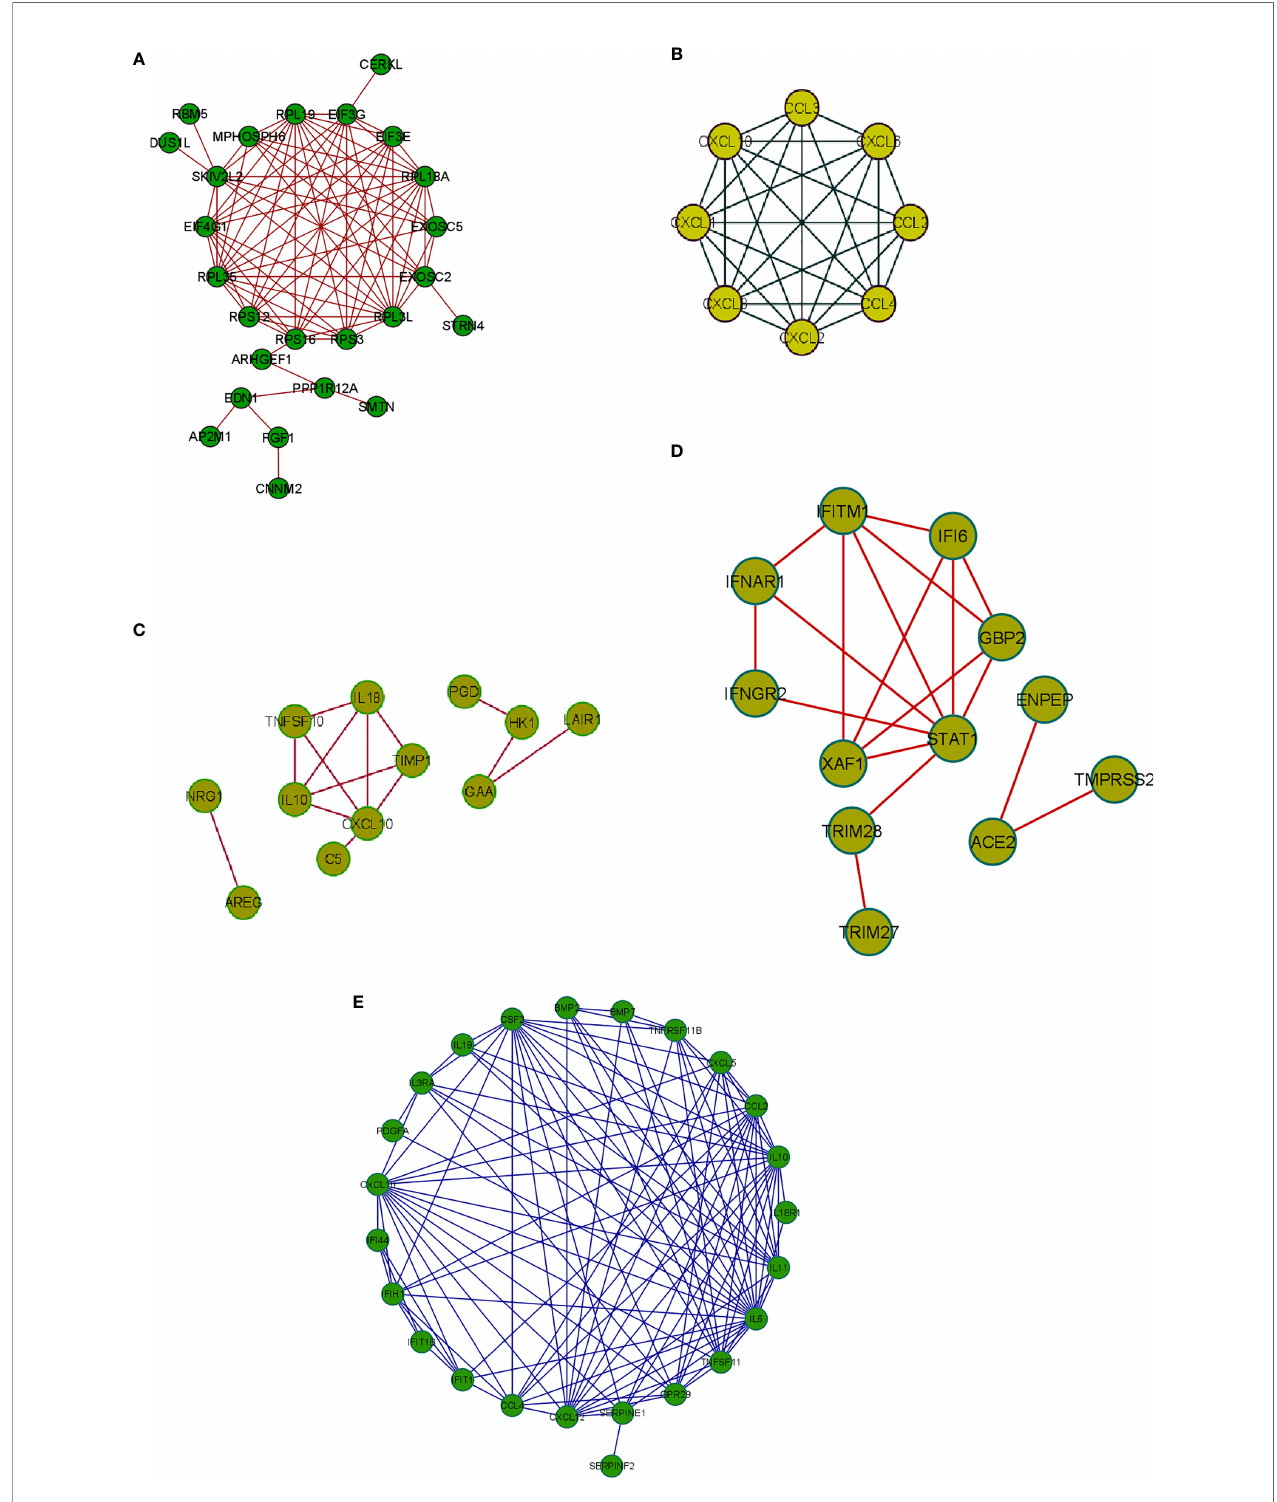
FIGURE 7 | The PPI network constructed using protein-coding DEGs from our study and other studies. (A) The PPI network with signi fi cant protein-coding DEGs in our research. (B) The PPI network from Xiong et al. study where the samples were the bronchoalveolar lavage fl uid. (C) The PPI network with the top-ranked genes of the Xiong et al. study from the PBMC samples. (D) The PPI network with data from the Ziegler et al. study and the gene expression data was collected from the lung lobe, nasal polyps, ethmoid sinus surgical tissue, and ileum. (E) The PPI network with the top-ranked protein-coding genes used a nasopharyngeal swab sample (the Jain et al.